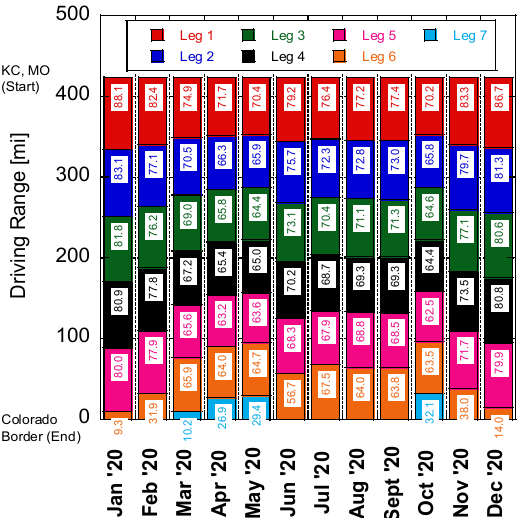
Figure 12. Traveling from Kansas City, MO, to the Colorado border on I-70 West with the respective range shown before charging is necessary. HVAC system is not engaged.